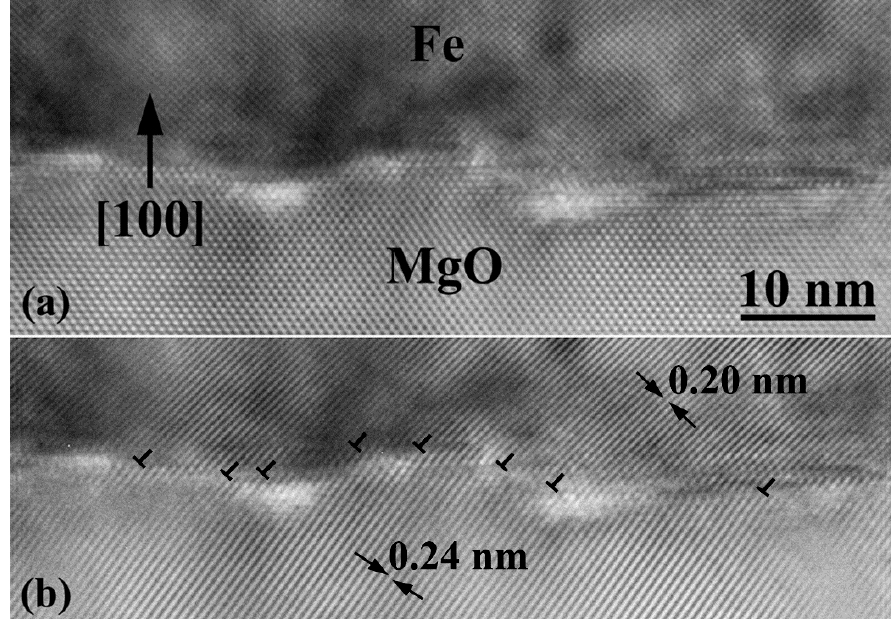
Figure 1. ( a ) HRTEM image of the MgO/Fe interface viewed along the [011]MgO/[001]Fe zone axis. A rough interface integrating steps and (100) terraces is observed. ( b ) A Bragg filtered image of ( a ), showing the coincidence of the MgO {111} ( d = 0.2427 nm) and Fe {110} ( d = 0.2027 nm) crystal planes at the interface, where misfit dislocations (here, viewed inclined) are inserted to accommodate the lattice mismatch.